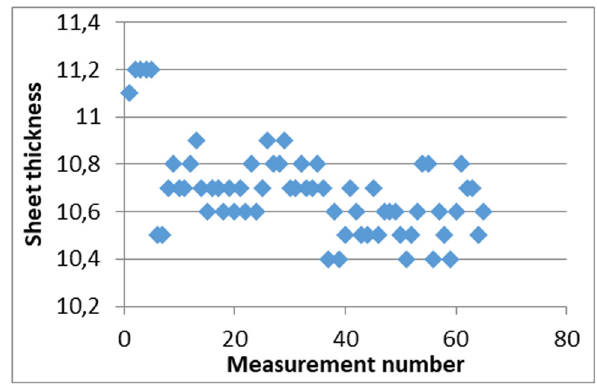
Figure 5: A list of thickness measurements for the fi rst coating sheet of tank two ( taken in 2007 ) .